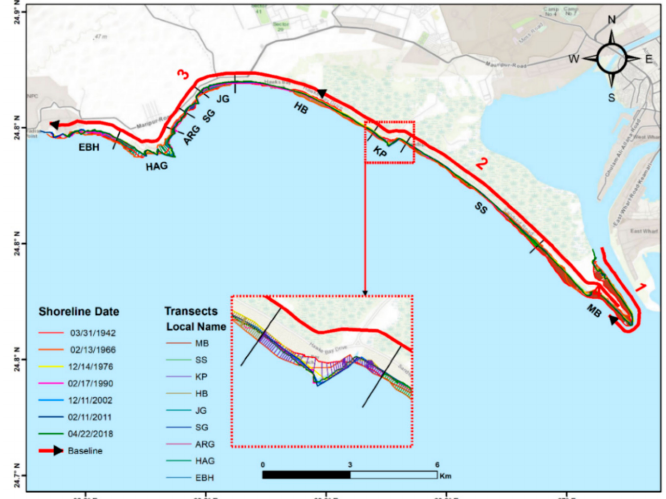
Figure 4. Digital shoreline analysis on the western zone (inset red doted rectangle shows a part of the study area) (MB = Manora Beach, SS = Sandspit, KK = Kaka Pir, HB = Hawks Bay, JG = Jamali Goth, SG = Somar Goth, ARG = Abdul Rehman Goth, HAJ = Haji Ali Goth, and EBH = Engro Beach Huts) (Table